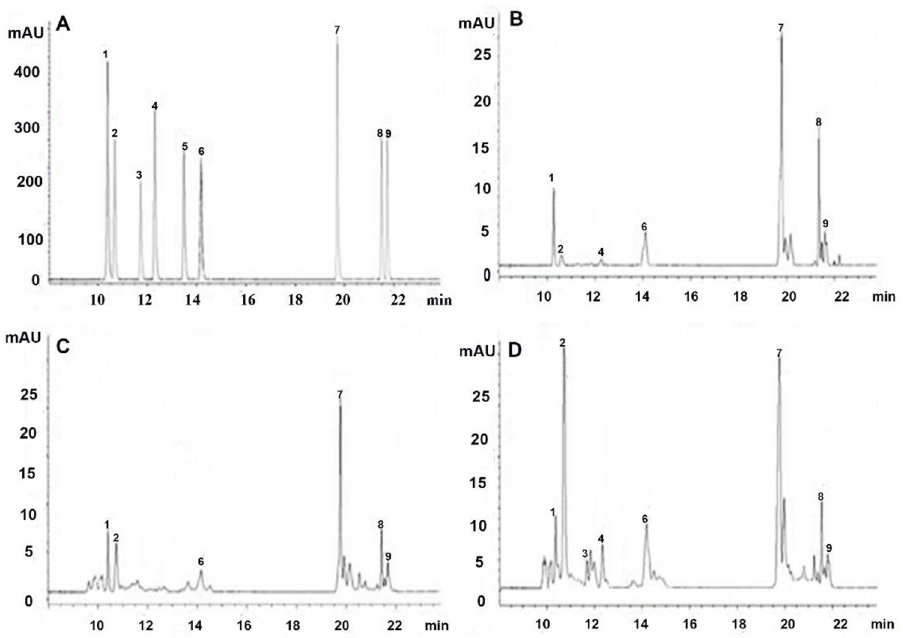
Fig 2. UPLC (280 nm) chromatograms of various samples: (A) standard sample with peak identification of components (1) IsoO(10.4 min), (2) Or (10.7 min), (3) Rut (11.7 min), (4)IsoQ (12.3 min), (5) Km3 (13.5 min), (6) Ast (14.2 min), (7) Qu(19.7 min), (8) Ap(21.5 min) and (9) Km(21.7 min); (B) sample on October 15, 2017; (C) sample on January 15, 2018; (D) sample on April 30, 2018. 3.2.2 Seasonal dynamic content of individual flavonoids. The variation in the content of nine flavonoids from the 24 T . hemsleyanum samples are presented in Table 1. Individually, IsoO was identified in 21 samples, and showed a peak of 86.7 μ g/g during the second half of December and reached a maximum of 119.6 μ g/g in the second half of April; Or was present in all 24 samples, showing a peak of 78.7 μ g/g in the second half of December and reached the maximum of 79.2 μ g/g in the second half of March; Rut at < 26.5 μ g/g was present in 18 sam- ples; IsoQ at < 30.7 μ g/g was observed in 15 samples; Km3rut at concentration < 6.5 μ g/g was found only in 4 samples collected during August and September; Ast was identified in 23 sam- ples, showing a peak of 54.6 μ g/g in the first half of June and reached a maximum of 71.8 μ g/g in the first half of February; Qu was available in 23 samples, with a concentration of over 111 μ g/g in January, April, May, and June, and reached a maximum of 150.8 μ g/g in the second half of April; Ap at concentrations between 14.9 and 18.2 μ g/g was found in 13 samples; and Km at < 10.5 μ g/g was found in 11 samples. Among these individual flavonoids, Qu was the highest in most months, and especially accumulated at high levels in January, April, May, and June, while Km3rut was hardly generated or accumulated during most months. From the data in Table 1, the total content of flavonoids reached higher levels between 281.3 and 392.8 μ g/g from April to May, and the contributions of nine individual flavonoid compounds were significantly different and seasonally varied. For example, IsoO, Ast, and Qu at 7.9, 38.6, and 15.0% contributed to the highest total accumulation of flavonoids (392.8 μ g/g) in the second half of April, at 7.9, 38.6, and 15.0% contributed to the total accumulation (186.2 μ g/g) in the first half of February, and at 0, 6.0, and 22.0% contributed to the lowest total accumulation (33.2 μ g/g) in the first half of August, respectively. Such dynamic distribu- tions of various flavonoid compounds during different seasons provides an insight into their